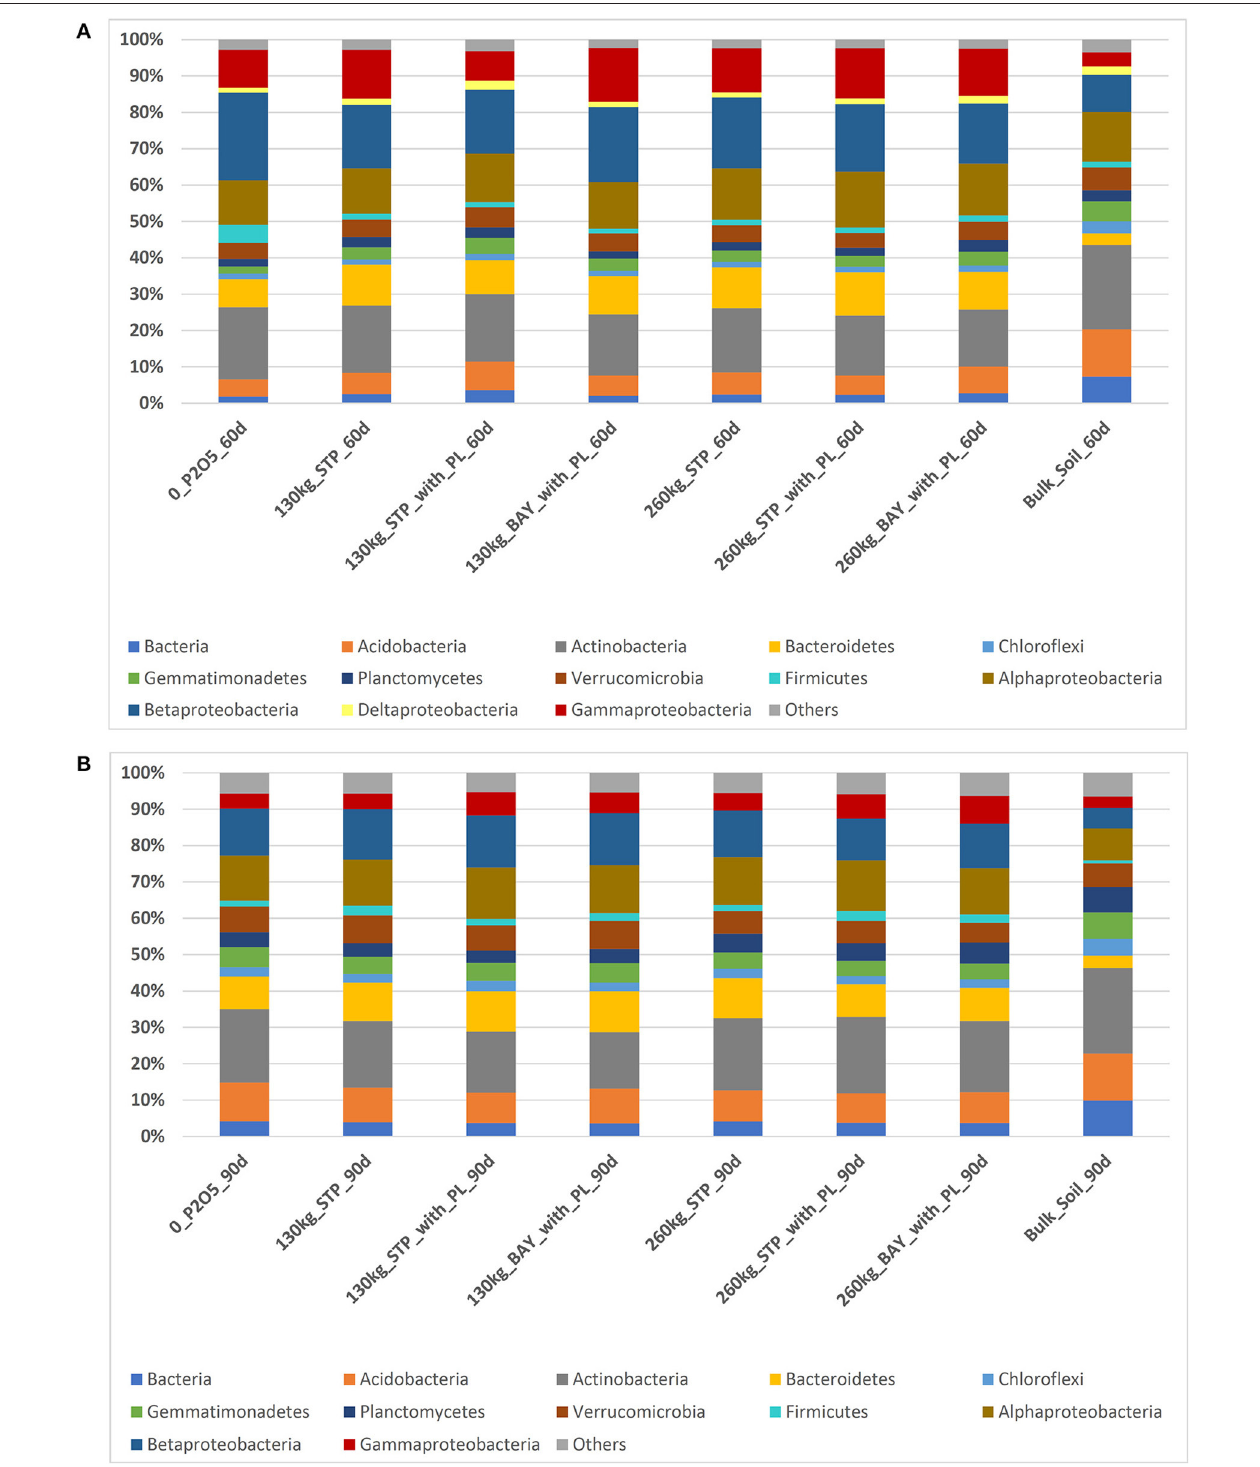
FIGURE 1 | Relative abundances of the most abundant bacterial phyla and Proteobacterial classes found in maize rhizosphere subjected to different phosphorus fertilizers and in bulk soil, as determined by high-throughput sequencing. (A) Samples taken 60 days after sowing maize, and (B) Samples taken 90 days after sowing